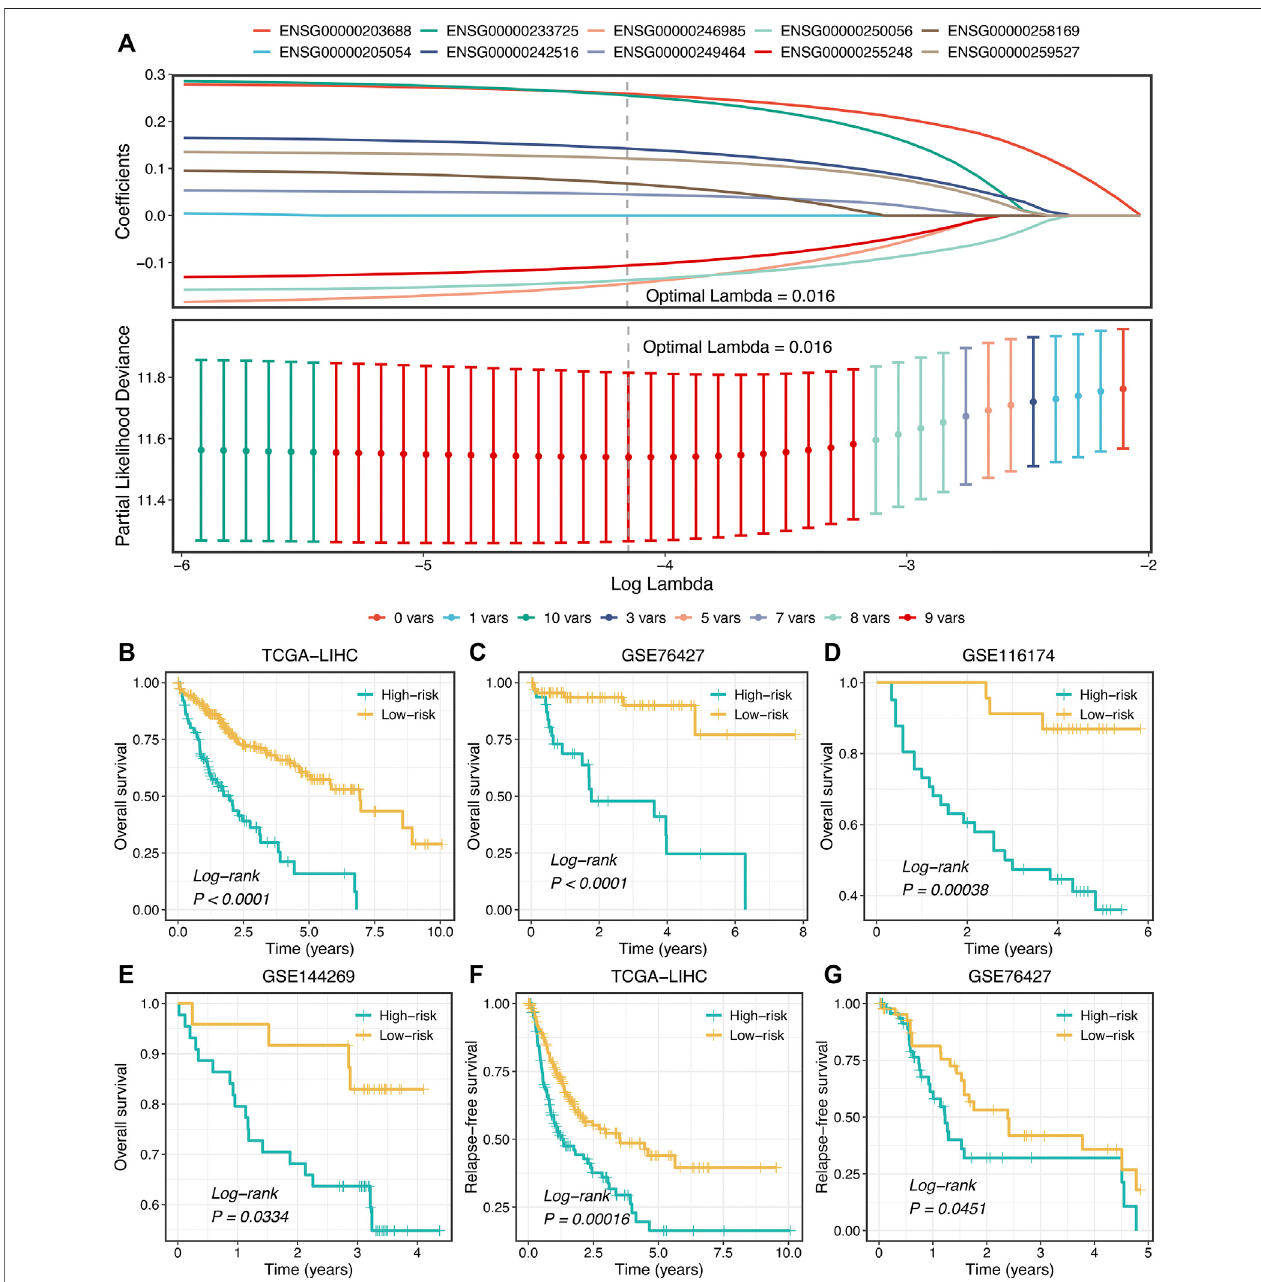
FIGURE7| Developmentofprognosticsignature. (A) LASSOcoef fi cientpro fi lesof10lncRNAsandpartiallikelihooddevianceforLASSOcoef fi cientpro fi les. (B – E) Kaplan-MeiercurvesofOSaccordingtoProLncSinTCGA-LIHC (B) ,GSE76427 (C) ,GSE116174 (D) ,andGSE144269 (E) . (F,G) Kaplan-MeiercurvesofRFSbetween the two groups in TCGA-LIHC (F) and GSE76427 (G)